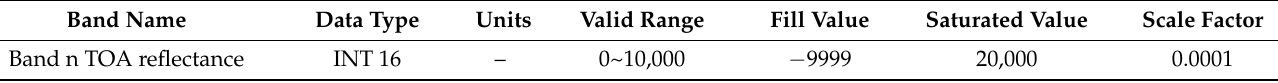
Table 4. ARD TOA reflectance bands for GF1-WFV and angular bands. INT16 means 16-bit signed